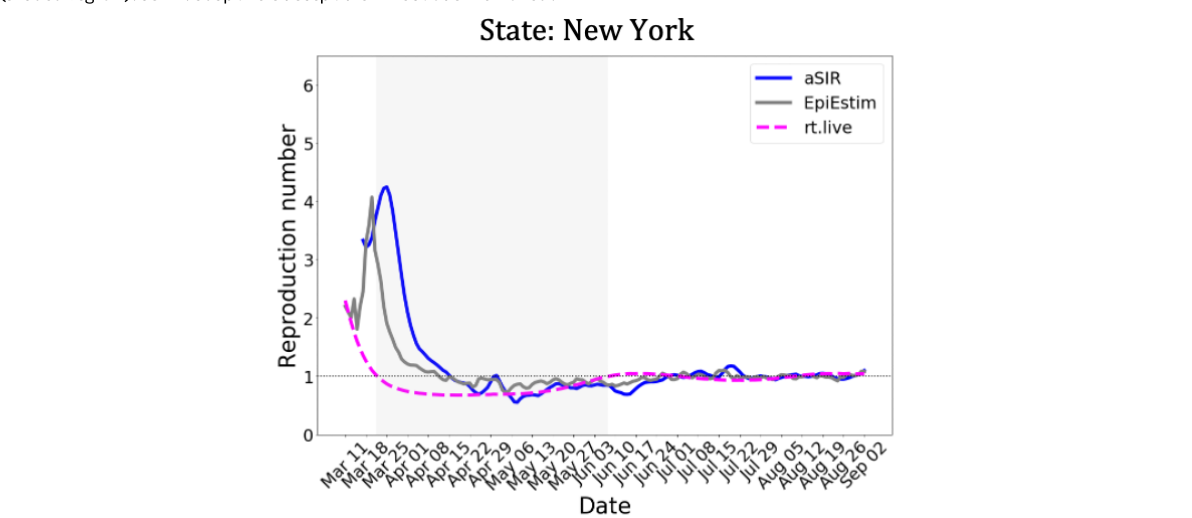
Figure 2. Comparison of models that generate continuous R t estimates. The three R t estimates differ widely in the beginning of the COVID-19 pandemic. In particular, the R t estimated using the rt.live model of Systrom, Vladeck, and Krieger [24] decreased to 1 at the onset at the lockdown on March 22, 2020 (shaded region). aSIR: adaptive Susceptible-Infectious-Removed.